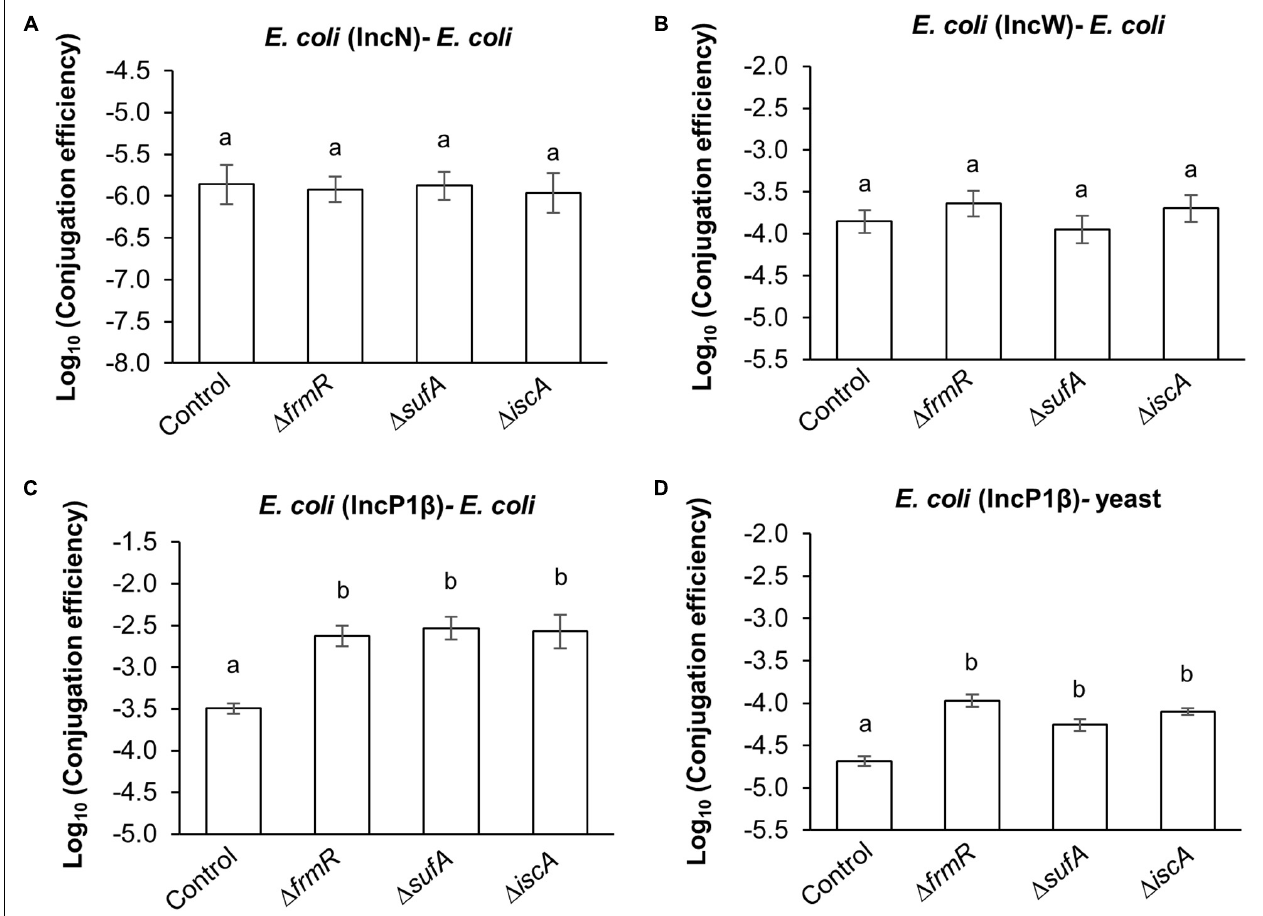
FIGURE 4 | Generality assessment of frmR , sufA , and iscA mutations on the conjugation of broad host range plasmids. (A) Conjugation efficiency of IncN (R46) plasmid transfer to E. coli recipient cells within five experimental replicates ( n = 5). (B) Conjugation efficiency of IncW (pSa) plasmid transfer to E. coli recipient cells within seven experimental replicates ( n = 7). (C) Conjugation efficiency of IncP1 β (pDPT51)-mediated shuttle vector (pAY205) transfer to E. coli and (D) yeast within triplicate experiments ( n = 3). BY4742 and SY327 were used as the recipients. All conjugation reactions were performed for 1 h. Data are presented as mean ± standard error of the mean (SEM). Different letters indicate significant differences between mutants and wild-type control at p < 0.05 using Tukey HSD multiple comparison analysis. BW25113 parental strain was used as the control.